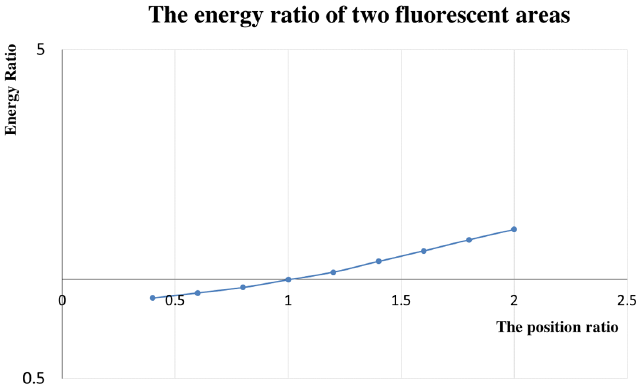
Fig. 8. Energy ratio of two °uorescent